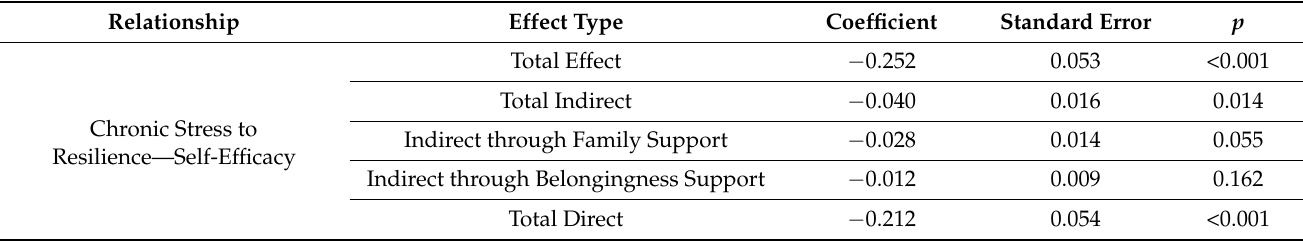
Table 3. Standardized effects—total direct and indirect effects for significant mediation